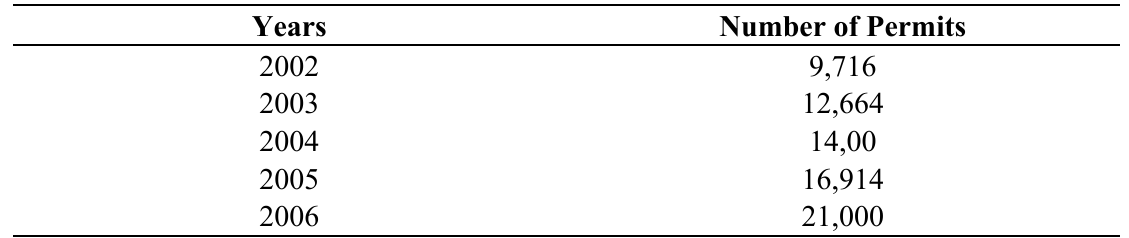
Table 11. The Distribution of Oil and Gas Permits